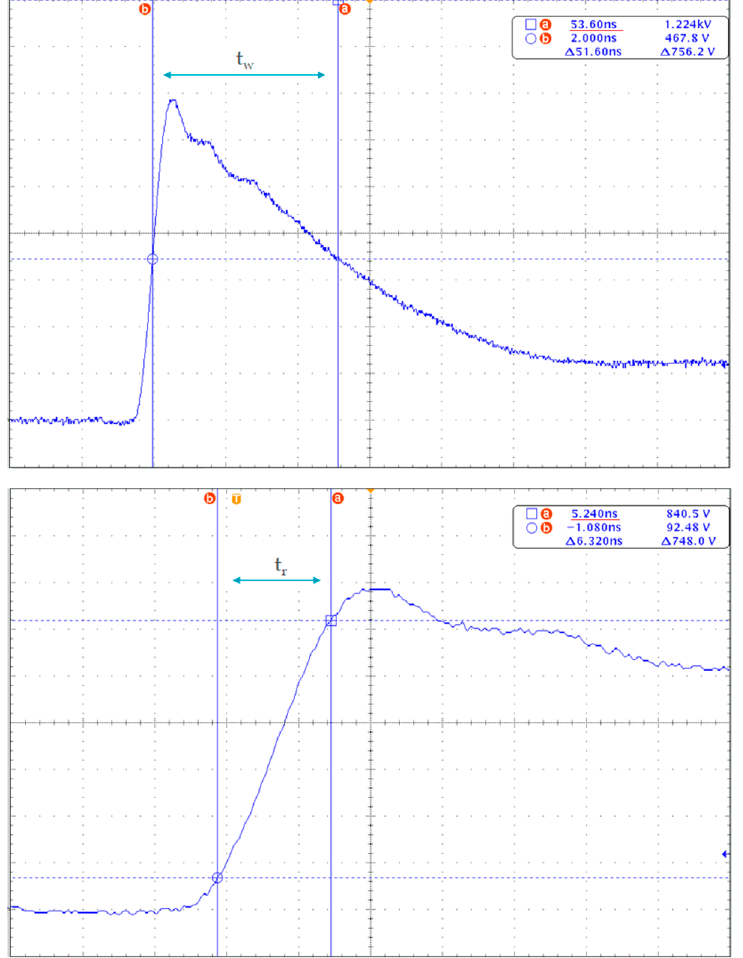
Figure 3. The ideal waveform of a single pulse into a 50 Ω load with nominal parameters t r = 5 ns and t w = 50 ns.